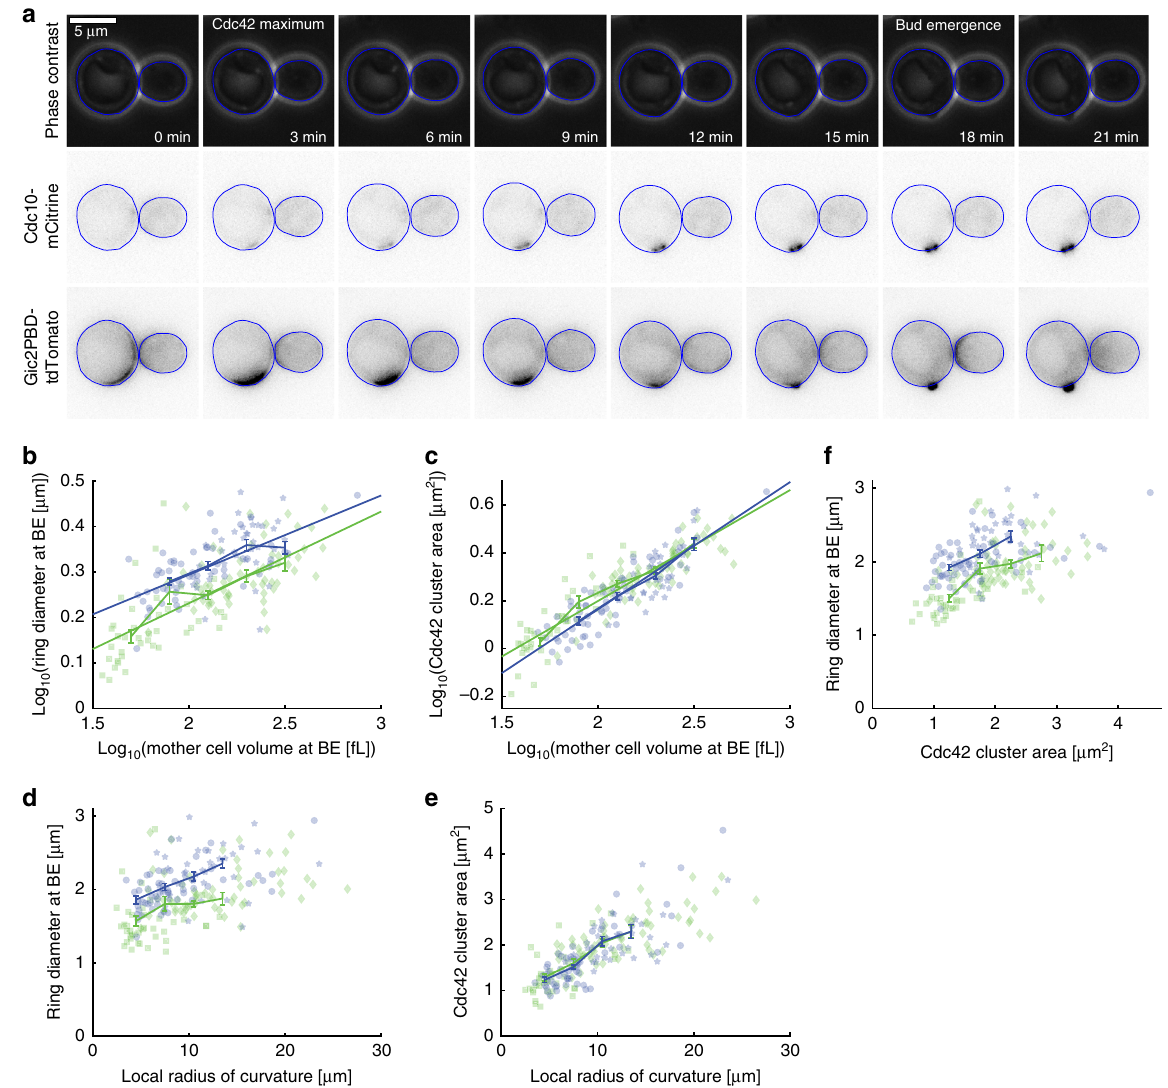
Fig. 9 bni1 Δ cells have larger septin ring diameters but similar Cdc42-cluster size. a Phase contrast and fl uorescence microscopy timecourse showing typical dynamics of Cdc42-GTP cluster formation as visualized by Gic2PBD-tdTomato, followed by septin ring formation visualized by Cdc10-mCitrine fl uorescence and bud emergence. Cell segmentations are shown in blue. b – e Cell volume was controlled through β -estradiol-dependent expression of Whi5. Cells that are otherwise wild-type are shown in green (squares: 0 nM β -estradiol, 39 cells; diamonds: 30 nM β -estradiol, 59 cells; each pooled from two independent experiments), bni1 Δ cells are shown in blue (circles: 0 nM β -estradiol, 57 cells; pentagrams: 30 nM β -estradiol, 38 cells; each pooled from two independent experiments). Septin ring diameter at the time of bud emergence based on Cdc10-mCitrine fl uorescence ( b ) and Cdc42-GTP cluster area at peak localization of Cdc42-GTP based on Gic2PBD-tdTomato fl uorescence ( c ) is shown as a function of mother cell volume at bud emergence. Septin ring diameter ( d ) and Cdc42-GTP cluster area ( e ) are shown as a function of local radius of cell curvature. f Septin ring diameter is shown as a function of Cdc42-cluster area. Error bars show binned means of pooled data with standard errors, solid lines show linear fi ts to the pooled double-logarithmic data. Cells were grown on SCGE. Source data are provided as a Source Data fi